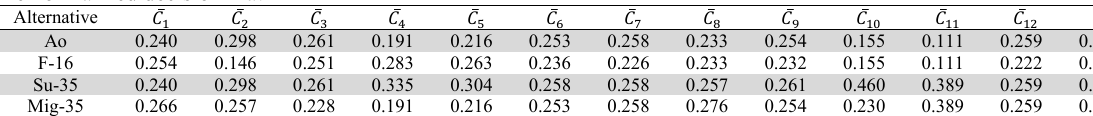
The normalized decision matrix Alternative